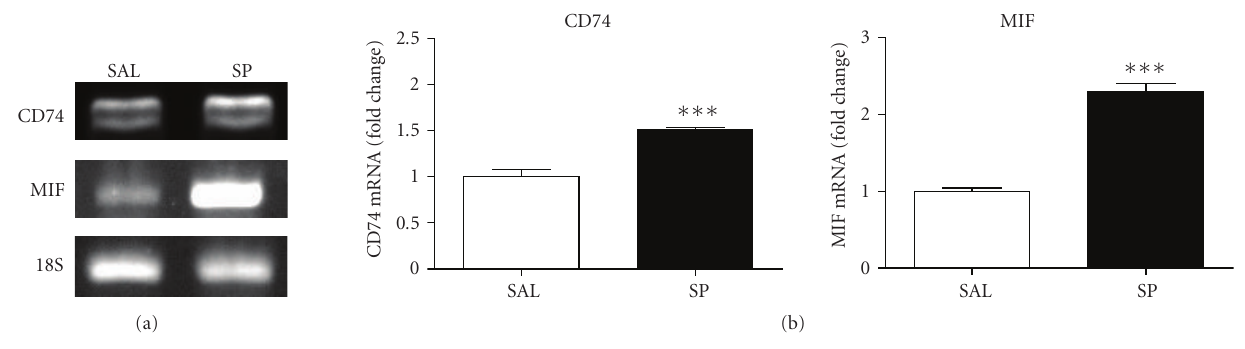
Figure 4: (a) MIF and CD74 mRNA expressions in isolated urothelial cells. Total RNA was isolated from urothelial cells and CD74 or MIF-specific primers used to amplify mRNA by endpoint PCR. A CD74 and MIF mRNA is increased in isolated urothelial cells after SP treatment. Data are representative of 5 salines and 5 SP-treated animals. 18S rRNA was used as a control for the amount of total RNA added to each reaction tube. (b) Relative expression of CD74 and MIF in isolated urothelial cells. Data are expressed as fold change calculated by determining mean gene expression ratio (net intensity of gene-specific band divided by net intensity of 18S rRNA band) normalized to saline controls. ( ∗∗∗ P < . 001, n = 5).